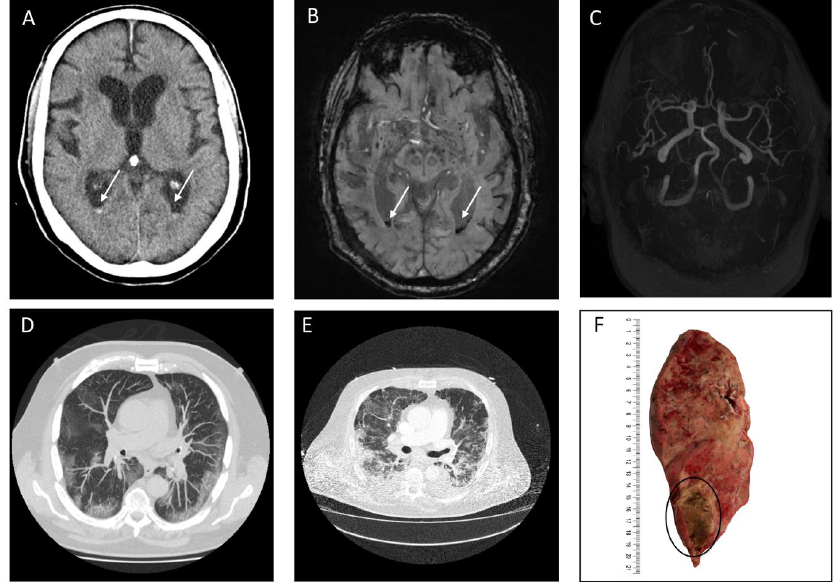
Figure 4. Representative computed tomography (CT) and Magnetic Resonance Imaging (MRI) images of a patient with Coronavirus Disease 2019 with an intraventricular hemorrhage (IVH). Legend: ( A,D,E) : Brain CT image ( A ) with corresponding chest CT image 30 days after hospitalization ( D ). ( B,C,E ): Brain MRI image with susceptibility weighted imaging (SWI) ( B ) and Time of flight angiography (TOF) ( C ) with corresponding chest CT image ( E ) 32 days after hospitalization. F : Longitudinal section of the right lung indicative of purulent pneumonia with abscess formation in the lower lobe. White arrow indicates acute intraventricular hemorrhage and black circle indicates abscess formation.